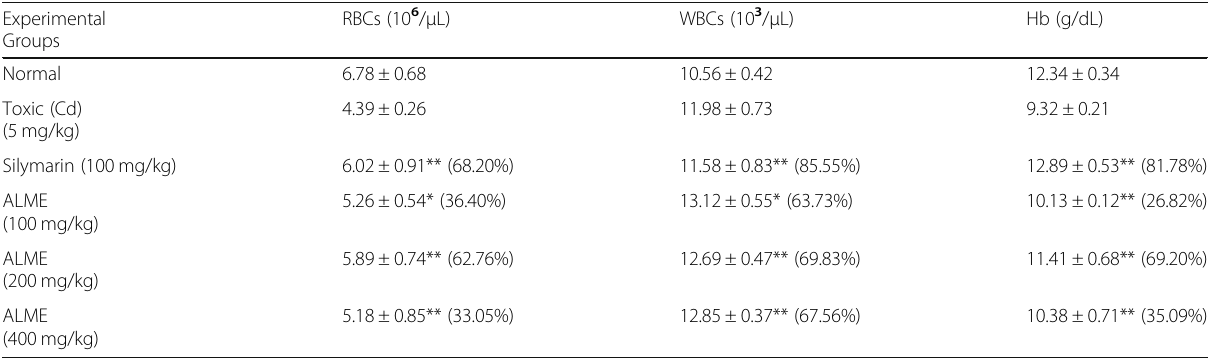
Table 6 Effect of ALME on RBC, WBC and Hb content Experimental